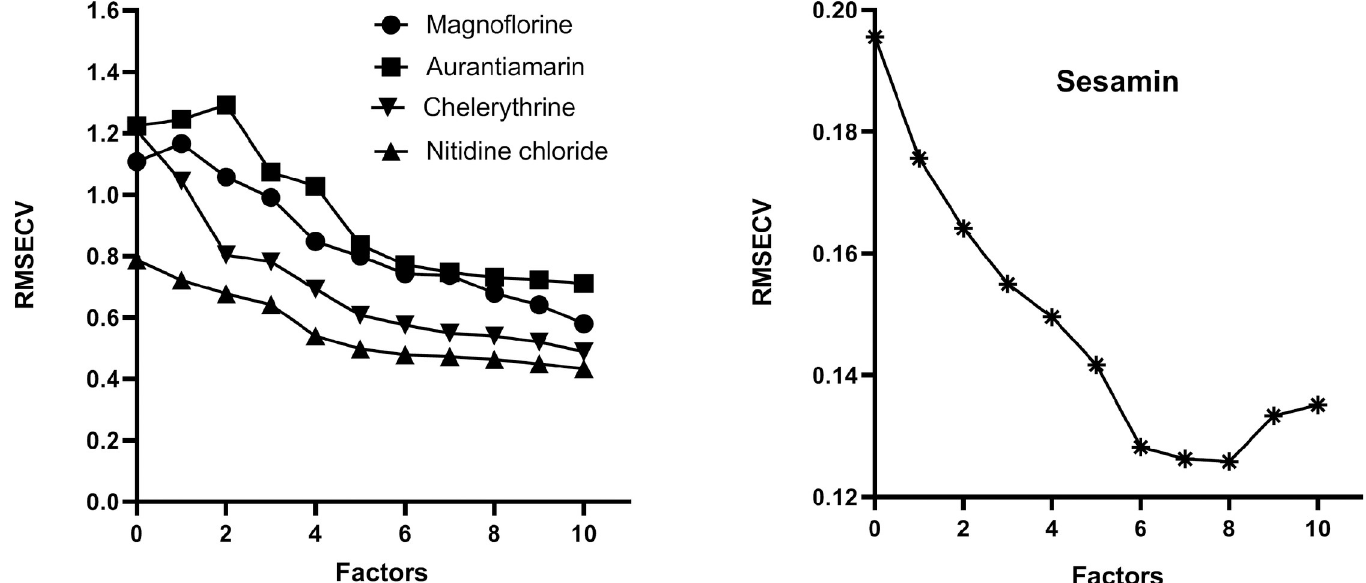
Fig 5. Effect of different principal factors on RMSECV of the calibration set. A. nitidine chloride, chelerythrine, magnoflorine and aurantiamarin; B.